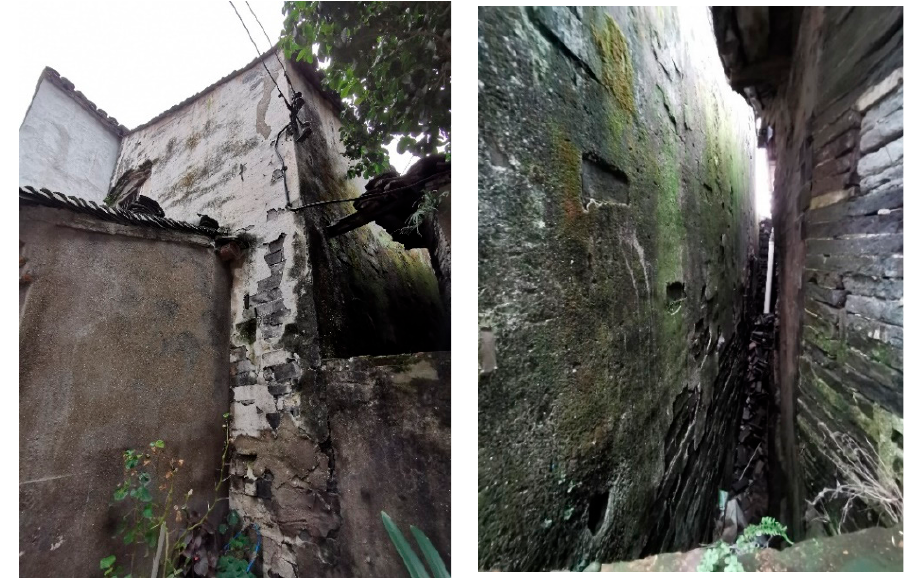
Figure 1. Rural residential building in southeast coast of China with keel brick walls.